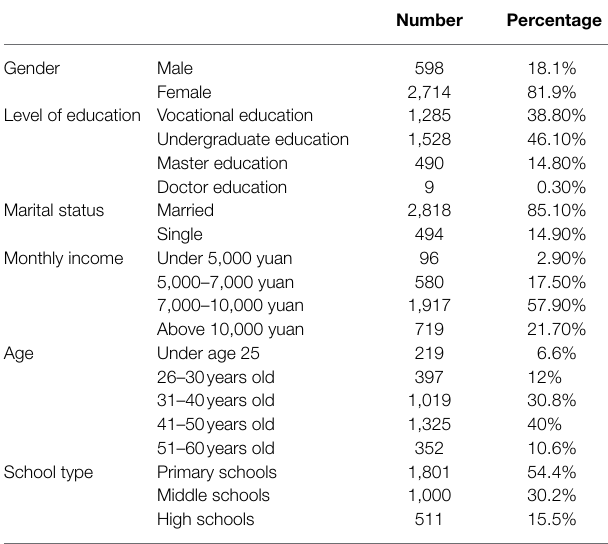
TABLE 1 | Sociodemographic characteristics of the